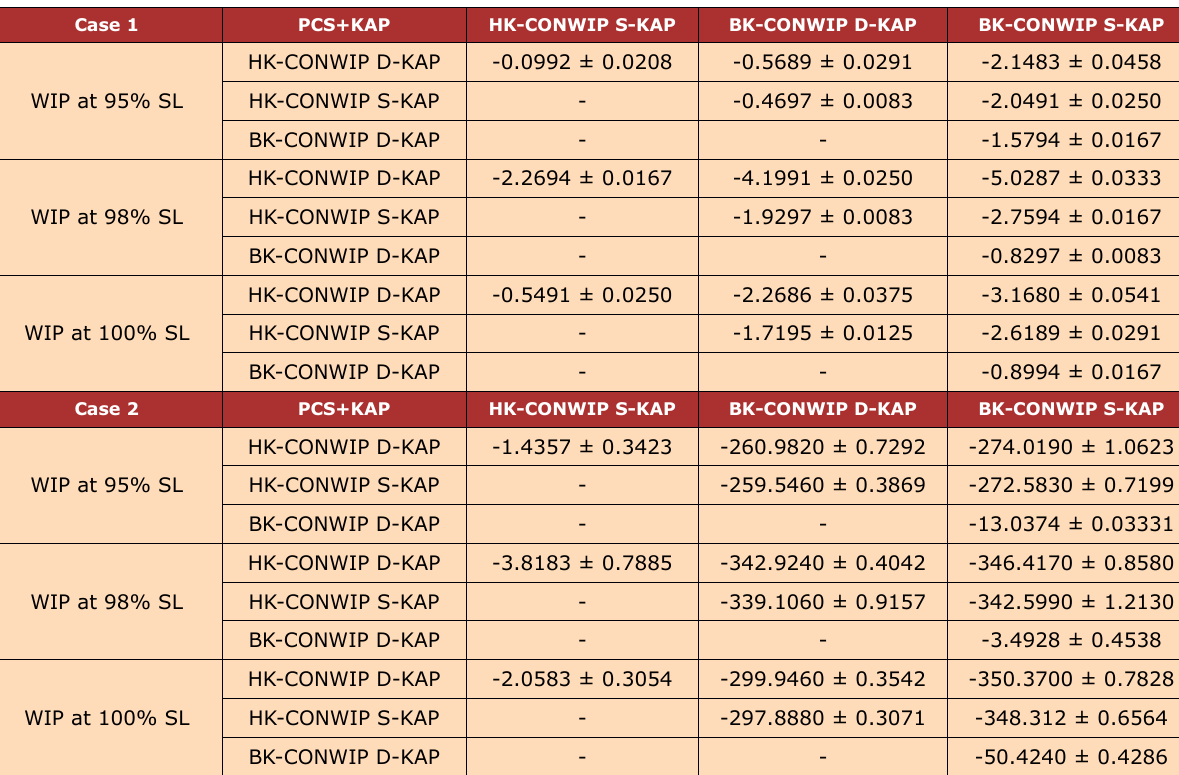
Table 10. Confidence interval of differences between average total WIP of PCS+KAP